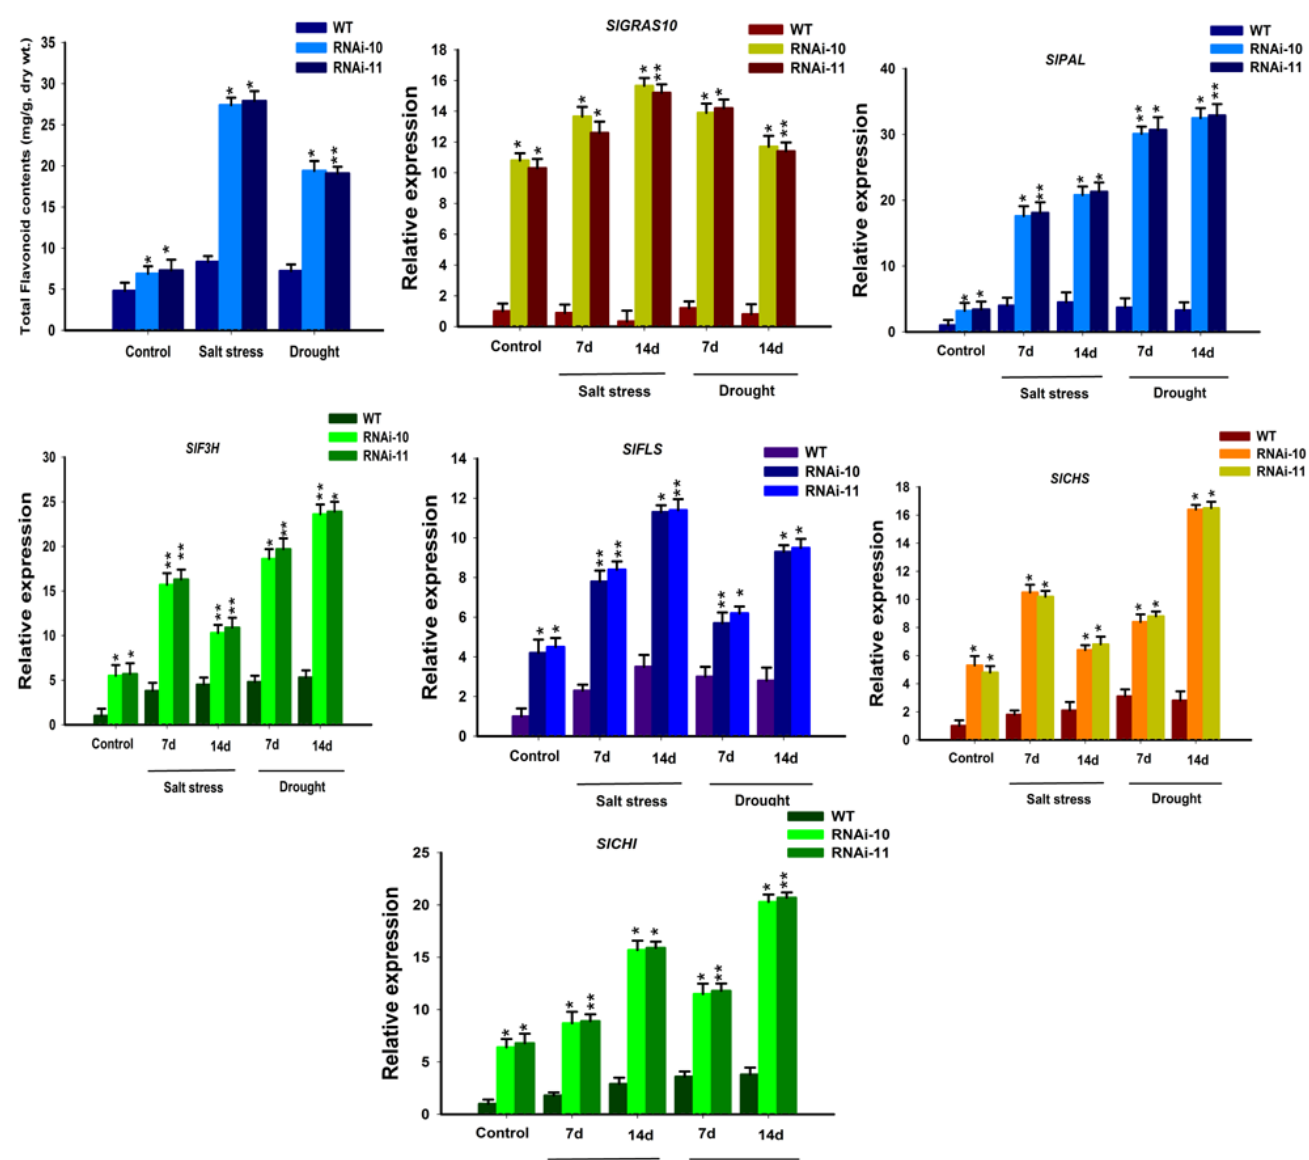
Figure 9. Down-regulation of SlGRAS10 elevates flavonoid accumulation. Total flavonoid contents and expression profile of flavonoid biosynthesis genes in SlGRAS10 -RNAi transgenic lines (L10, L11) and WT under control, salt, and drought. The date represents the mean ± SE of three independent replicates. *, ** indicates a significant difference ( p < 0.05, p < 0.01) between transgenic and wild-type plants.